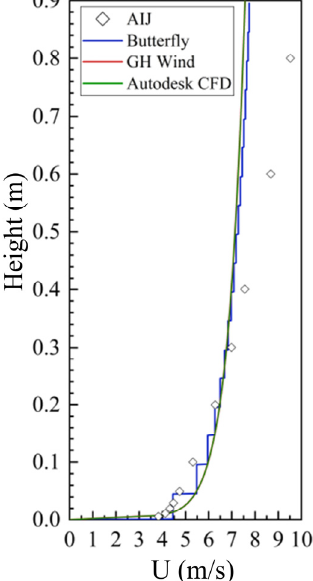
Figure 2. Diagram of inflow velocity profiles generated by different CFD plug-ins.